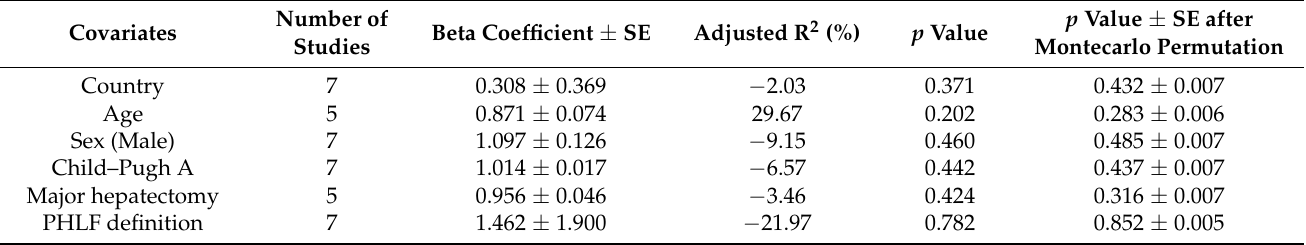
Table 3. Results of the univariable meta-regression